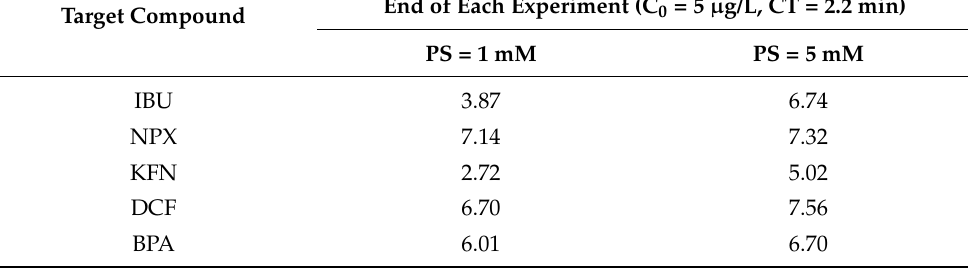
Table 7. The ratio of mass of pollutant removed per mass of the nanocomposite material (R-nFe) at the end of each experiment, testing two different sodium persulfate concentrations (initial concentration of each pollutant 5 µ g/L, contact time 2.2 min, and pH adjustment to 3.5). Mass of Pollutant Removed per Mass of R-nFe ( µ g/g) at the End of Each Experiment (C 0 = 5 µ g/L, CT = 2.2 Target Compound